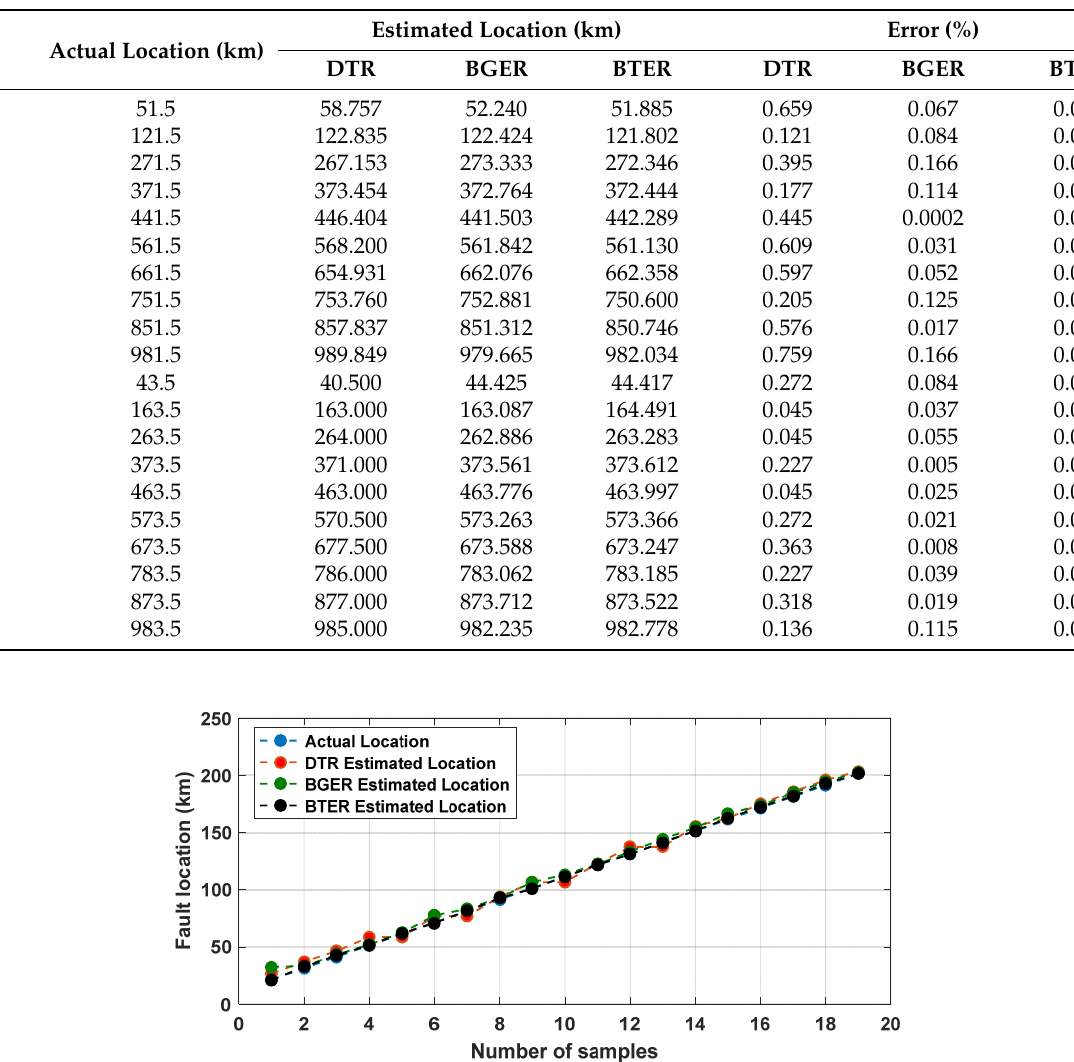
Table 5. Actual and estimated fault location for single pole to ground fault.